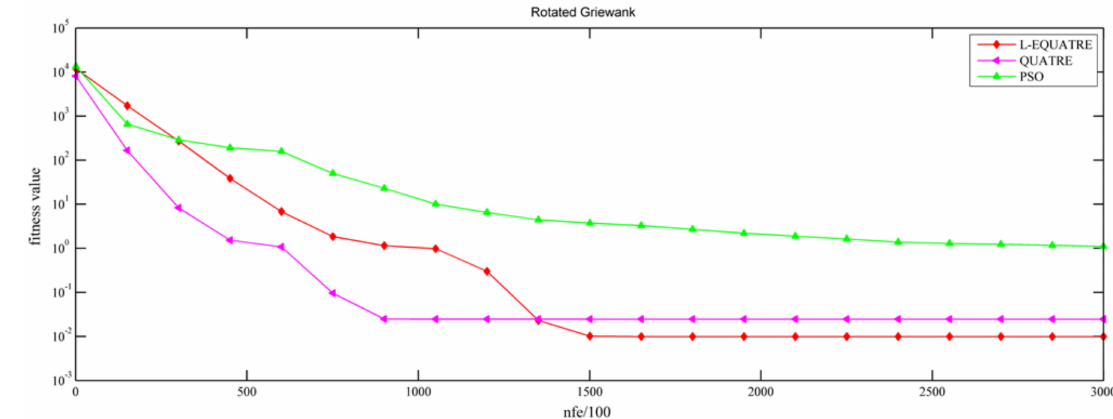
Figure 3. Rotated Griewank function.